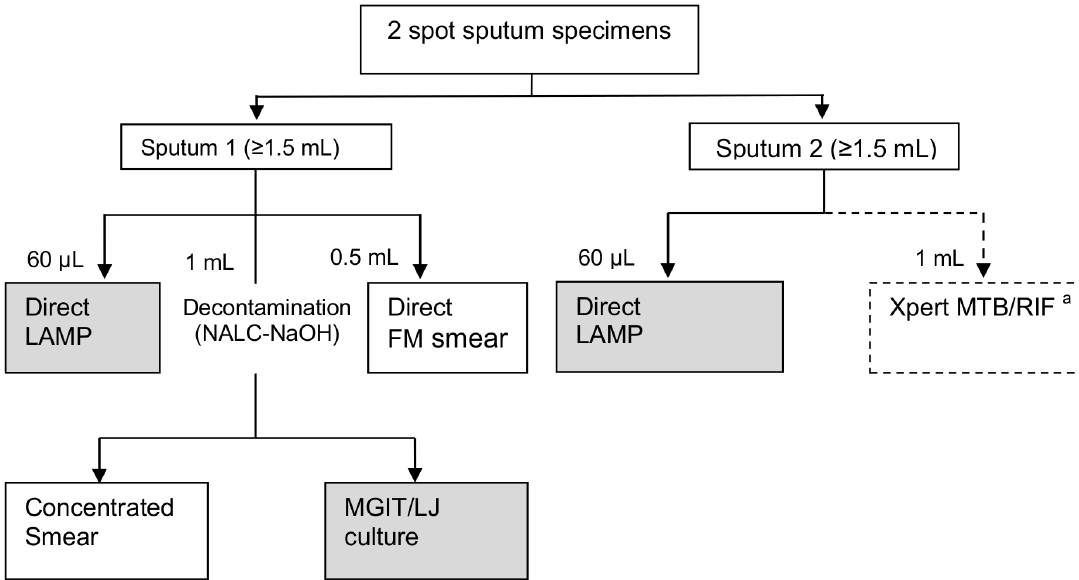
Fig 1. Laboratory workflow. Abbreviations: LAMP = Loop-mediated Isothermal Amplification assay; FM = fluorescence microscopy; MGIT = Mycobacteria Growth Indicator Tube; LJ = Lowenstein Jensen media; NALC-NaOH = n-acetyl-L-cysteine (NALC) — sodium hydroxide (NaOH). a Preference was given to investigations for ‘ sputum 1 ’ in case of inadequate volume or salivary specimen of one or more samples, since culture results were the predefined reference